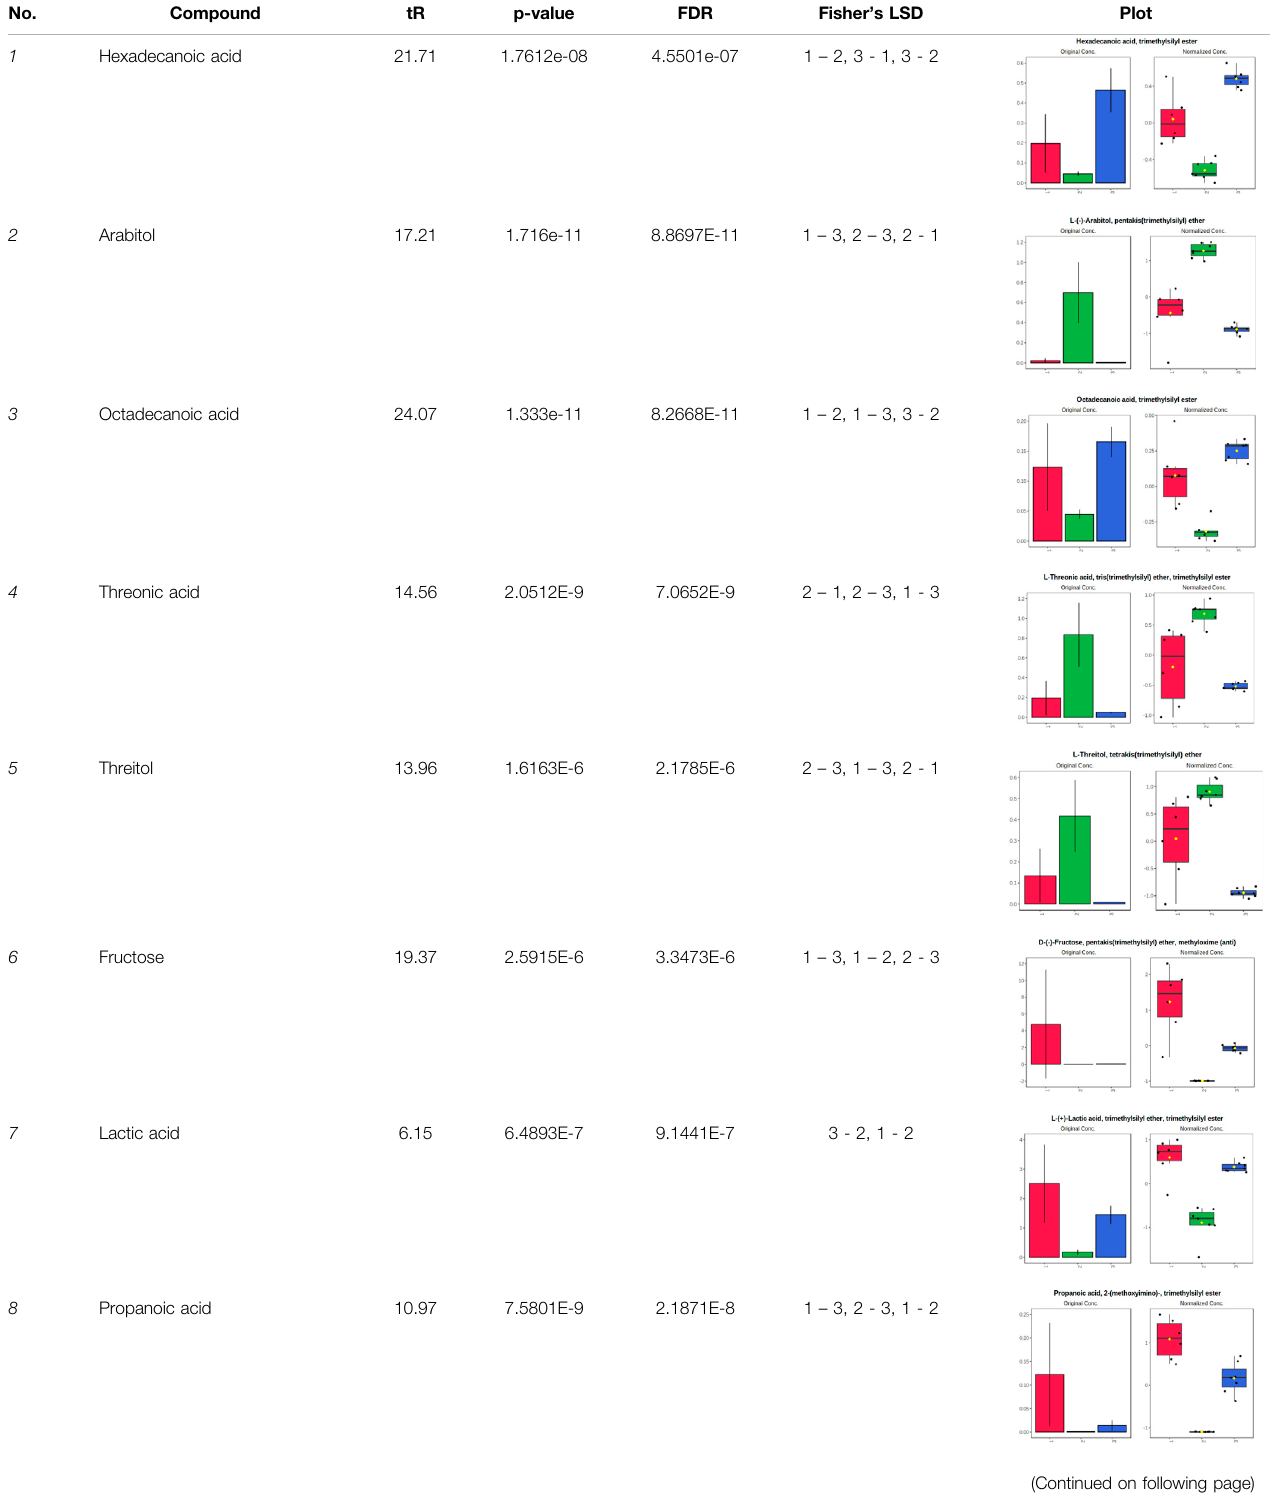
TABLE 4 | Statistically signi fi cant variables for all three tested matrices determined with the use of GC-QqQ/MS.